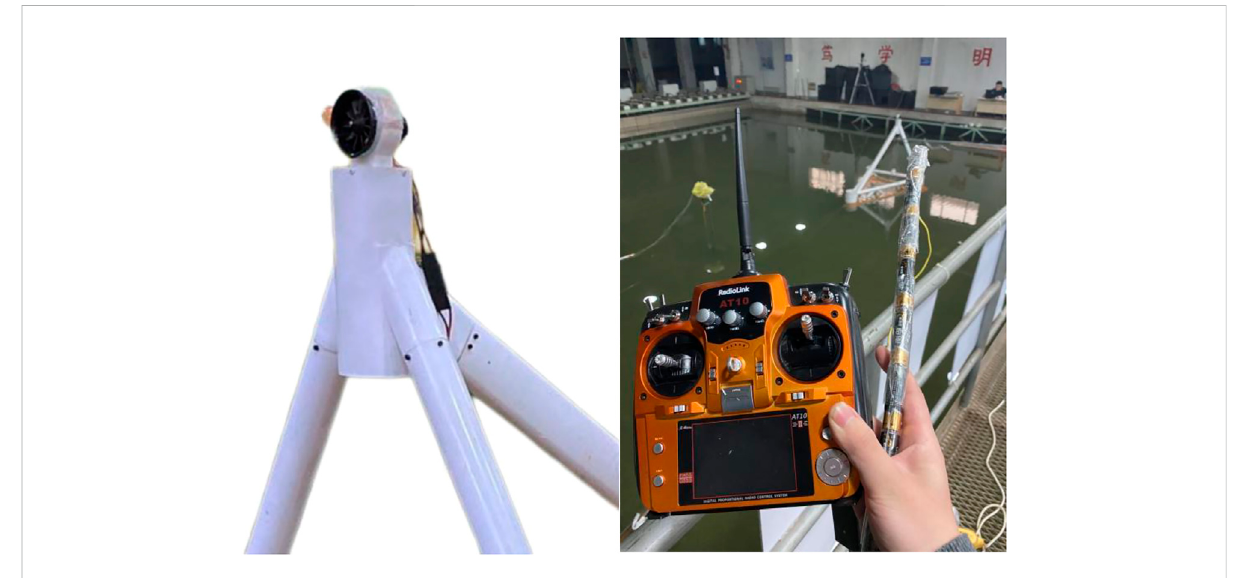
FIGURE 9 The ducted fan and the remote control equipment.